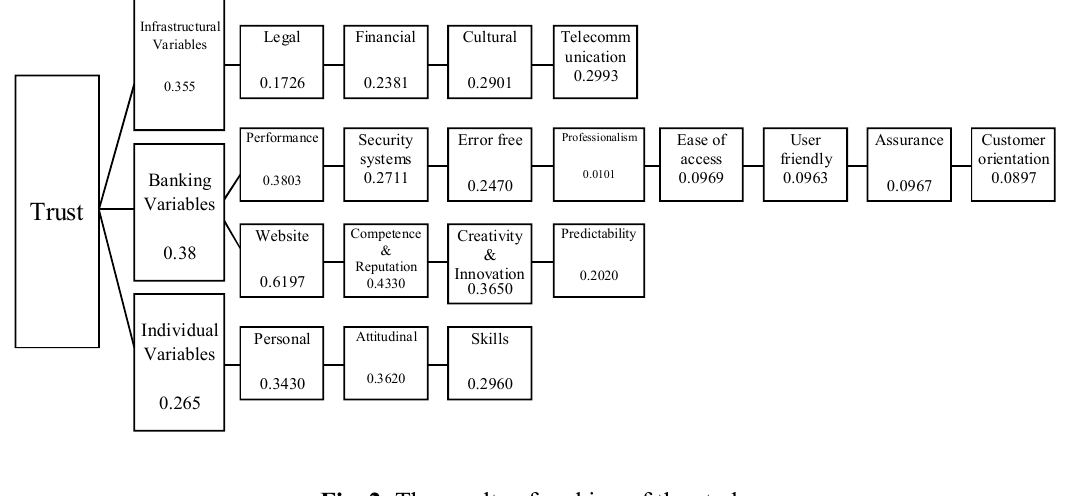
Fig. 2. The results of ranking of the